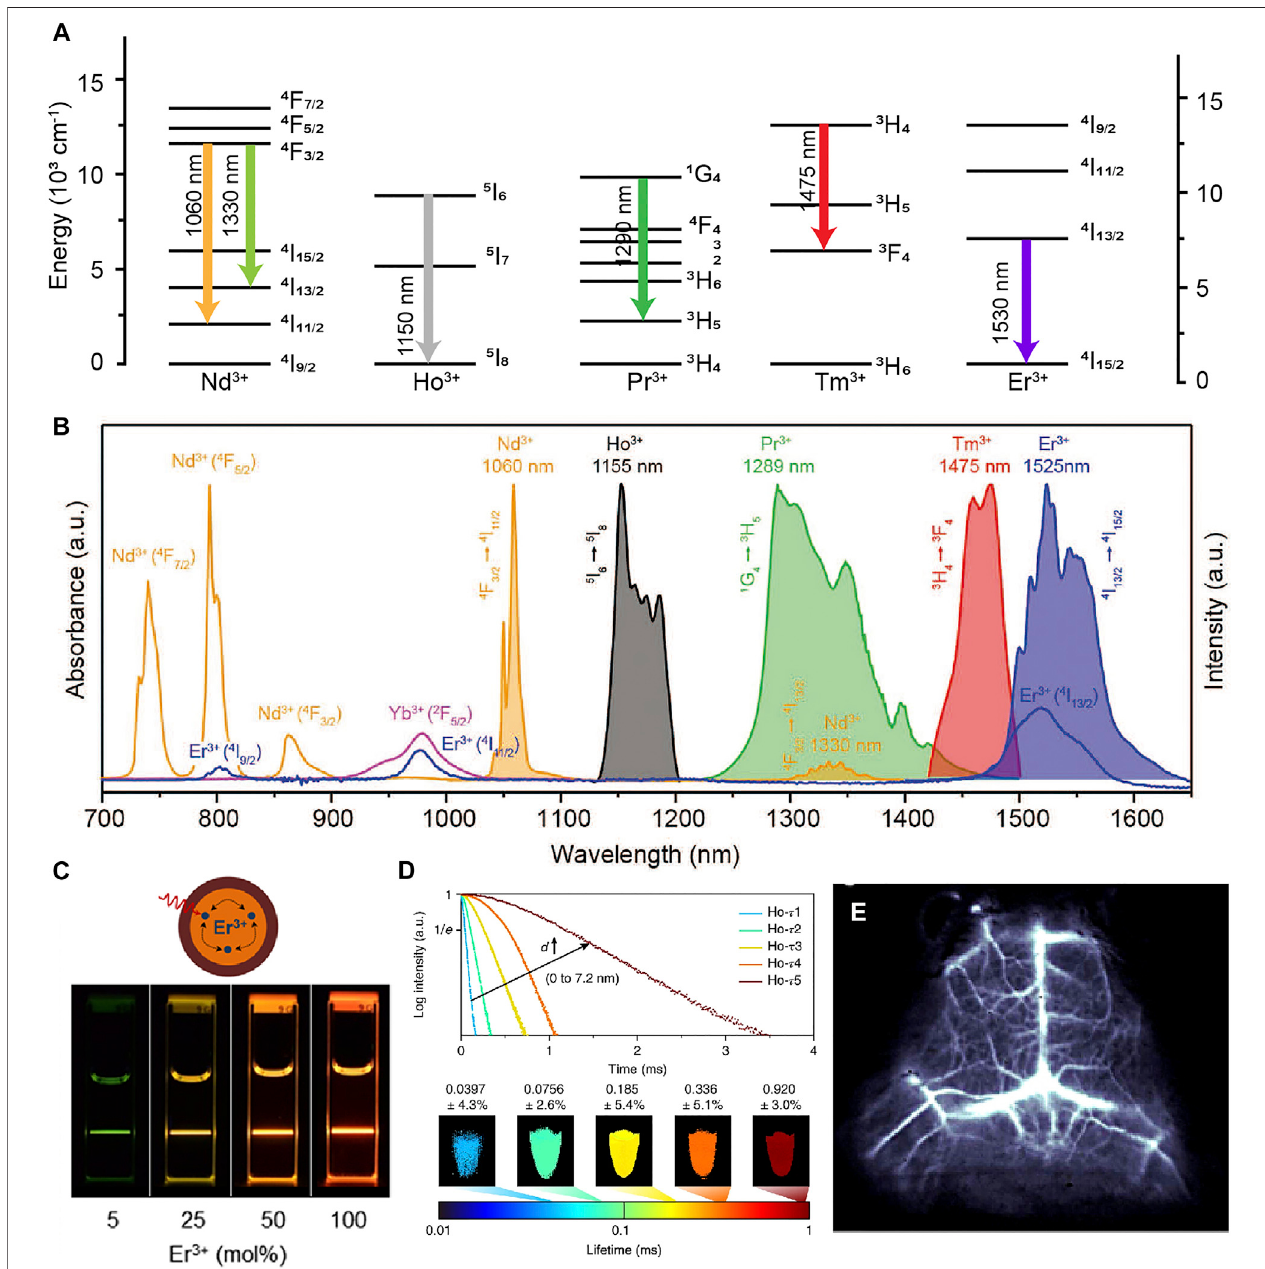
FIGURE 2 | (A) Schematic energy level diagrams of trivalent lanthanide ions activators (Ln (cid:1) Nd 3+ , Ho 3+ , Pr 3+ , Tm 3+ , Tm 3+ ). (B) Intrinsic NIR emissions from Nd 3+ , Ho 3+ , Pr 3+ , Tm 3+ , Tm 3+ (Fan and Zhang, 2019). Reproduced with permission from Fan and Zhang, (2019). (C) Schematic illustration of the NaErF 4 @NaLuF 4 core/shell nanocrystalsstructuralcomposition(Johnsonetal.,2017).ReproducedwithpermissionfromAlmutairietal.(2017). (D) LuminescencedecaycurvesofHo-dopedcore- multi-shell nanocrystals and lifetime images measured at 1,155 nm (Fan et al., 2018). Reproduced with permission from Zhang et al. (2018). (E) Cerebral vascular image in 1,550 nm of β -NaYbF 4 :Ce,Er@NaYF 4 nanoparticles (Zhong et al., 2017). Reproduced with permission from Dai et al. (2017).